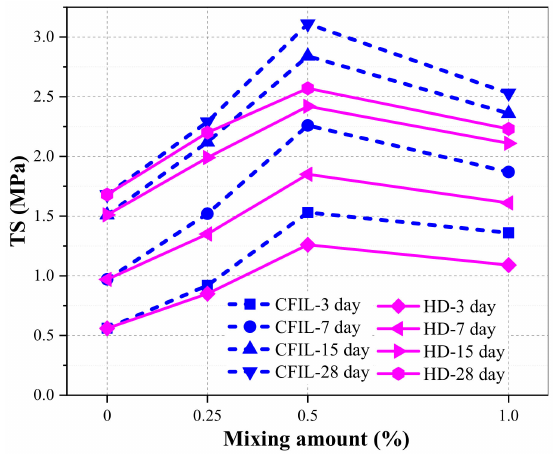
Figure 10. Relationship between TS and mixing